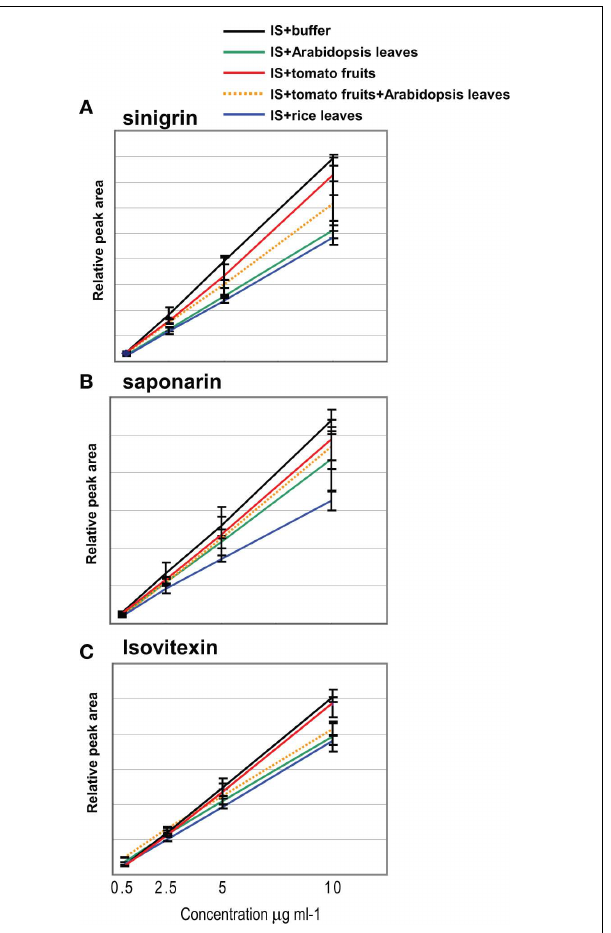
FIGURE 5 | Example of ion suppression caused by plant extracts. Standard solutions (20, 10, 5, 1 μ gml − 1 ) of three standard compounds, (A) sinigrin, (B) saponarin, and (C) isovitexin, were mixed to the same volume of plant extracts (0.2mg FW μ l − 1 ) of Arabidopsis leaves, tomato fruits, rice leaves and mixture of Arabidopsis leaves and tomato fruits (ratio 1/1). Average and ± SD were calculated from three experimental replicates.